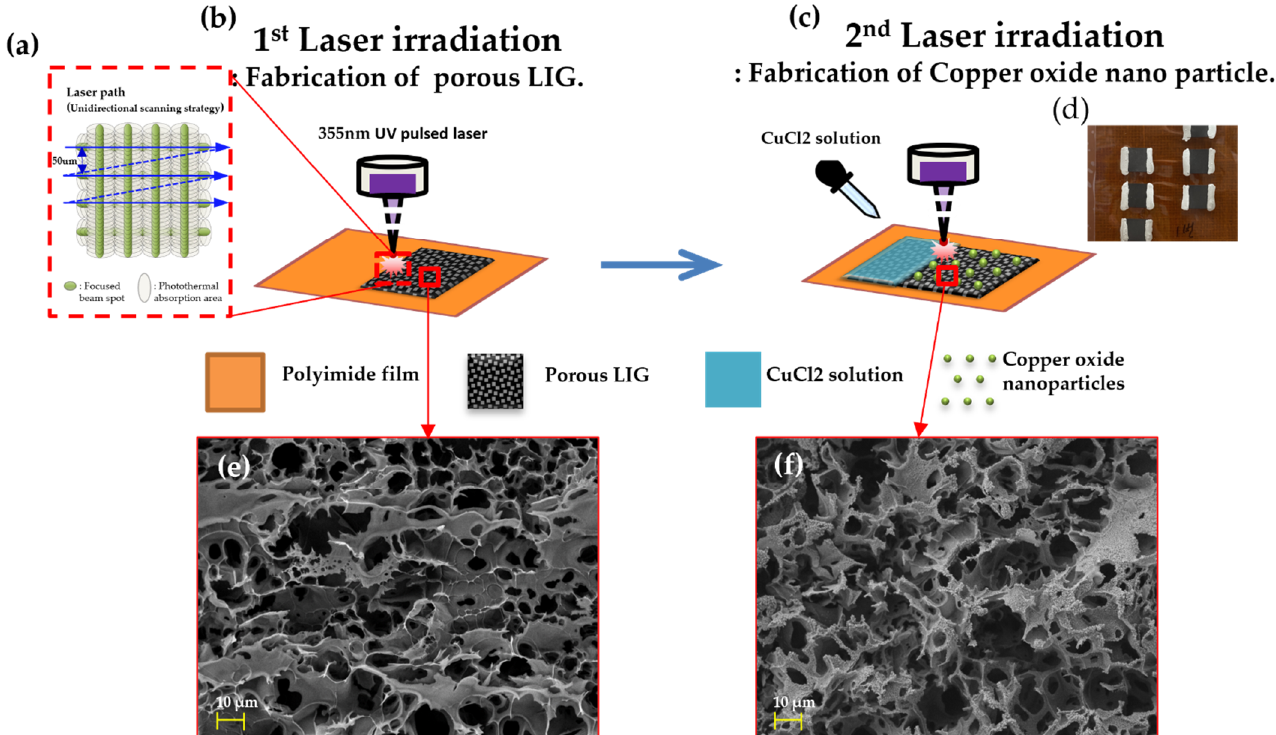
Figure 1. Fabrication of process of LIG deicing systems: ( a ) illustration of laser pulse spot; ( b ) first irradiation onto PI for porous LIG; ( c ) second laser irradiation with CuCl 2 solutions for the fabrication of Cu oxide nanoparticles; ( d ) actual photograph of Cu/LIG with silver paste electrode; FE-SEM images of ( e ) porous LIG and ( f ) Cu/LIG.